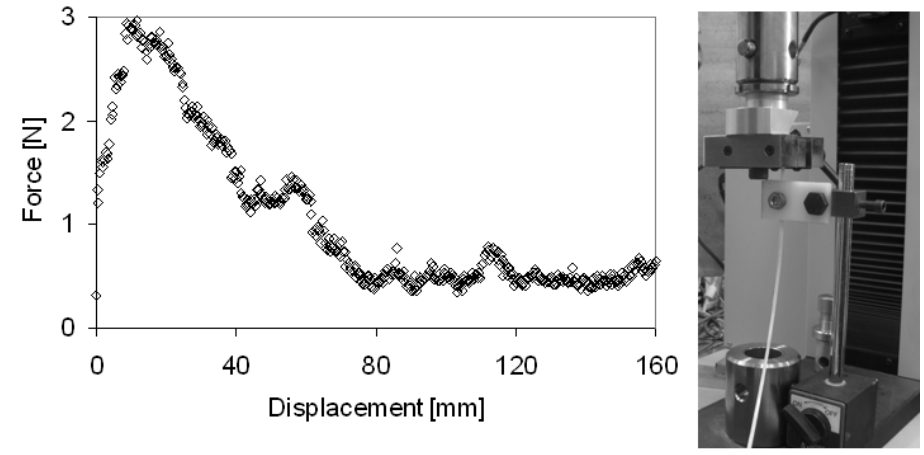
Figure 3. Evaluation of the consolidation force.